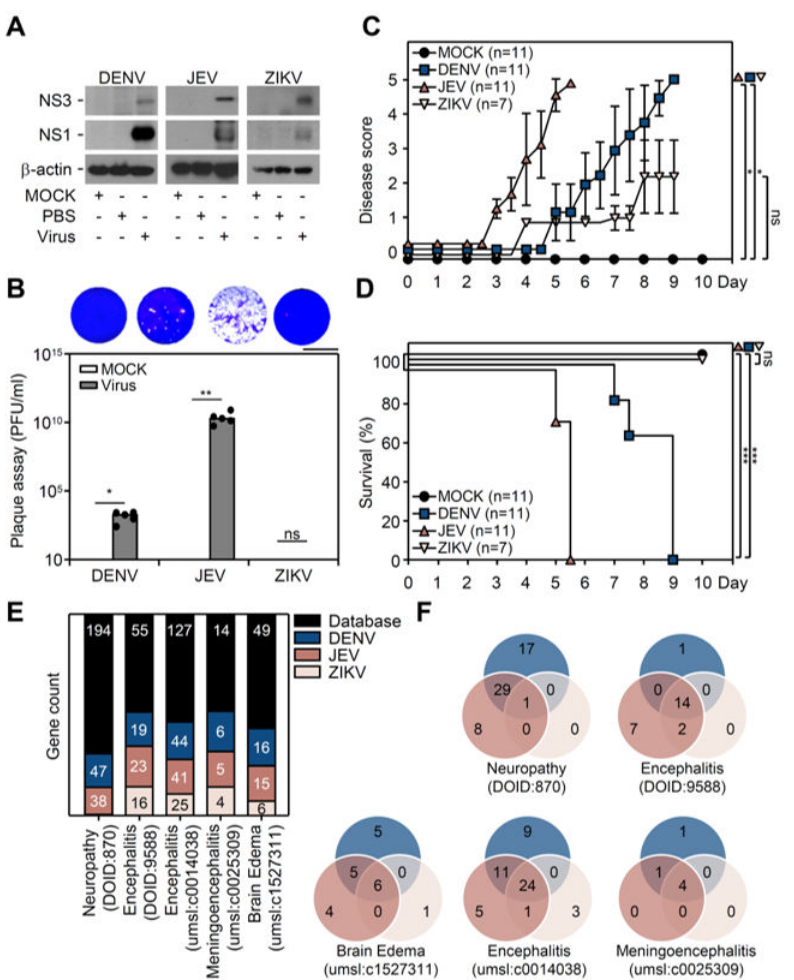
Figure 1. Flavivirus infection induced encephalitis-like symptoms in a suckling mouse model. Seven-day-old neonatal ICR mice were intraperitoneally (i.p.) and intracerebrally (i.c.) injected to inoculate without ( n = 11, MOCK) or with DENV ( n = 11, PL046, 1 × 10 6 pfu), JEV ( n = 11, RP-9, 1 × 10 4 pfu), or ZIKV ( n = 7, PRVABC-59, 1 × 10 6 pfu). ( A ) Representative blots showed viral nonstructural protein (NS) expression. β -actin was used as the internal control. ( B ) Plaque assay revealed mature virion production at the indicated sacrifice timepoint. ( C ) The disease score showed the progression of disease onset. ( D ) Percentage of survival rate showed mouse mortality after viral infection. ( E ) Disease ontology analysis showed the gene expression profiles related to brain injury in different flavivirus infections. ( F ) Venn diagrams represented the similar expression patterns of a disease-related gene in different flavivirus infections. * p < 0.05, ** p < 0.01, and *** p < 0.001; ns, not significant. Scale bar =